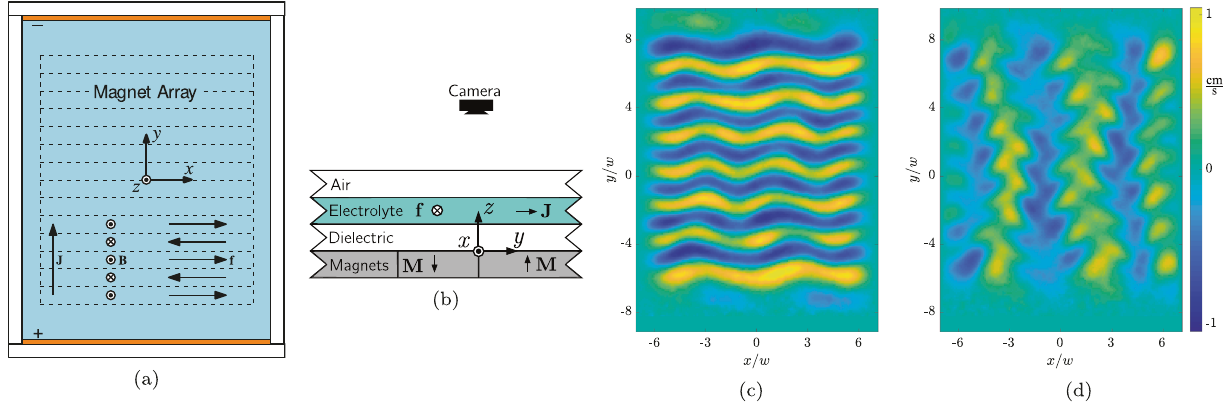
Fig. 1 Experimental setup and sample data. Schematic top ( a ) and side ( b ) views are shown for laboratory studies of weak turbulence in a thin electrolyte layer inside a rectangular container. Flow is driven by Lorentz forcing f , which arises by applying a current density J in the presence of a magnetic fi eld B from a permanent magnet array (dashed lines). The heatmaps illustrate snapshots of measured velocity fi elds in the x - ( c ) and y - ( d ) directions at Reynolds number Re = 22.17, when the fl ow is weakly